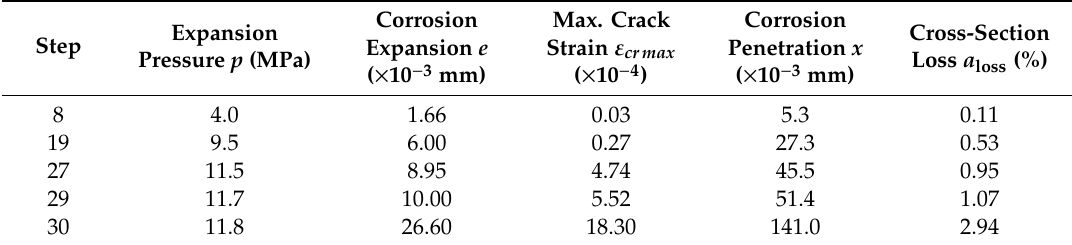
Table 2. Corrosion expansion properties for each step.